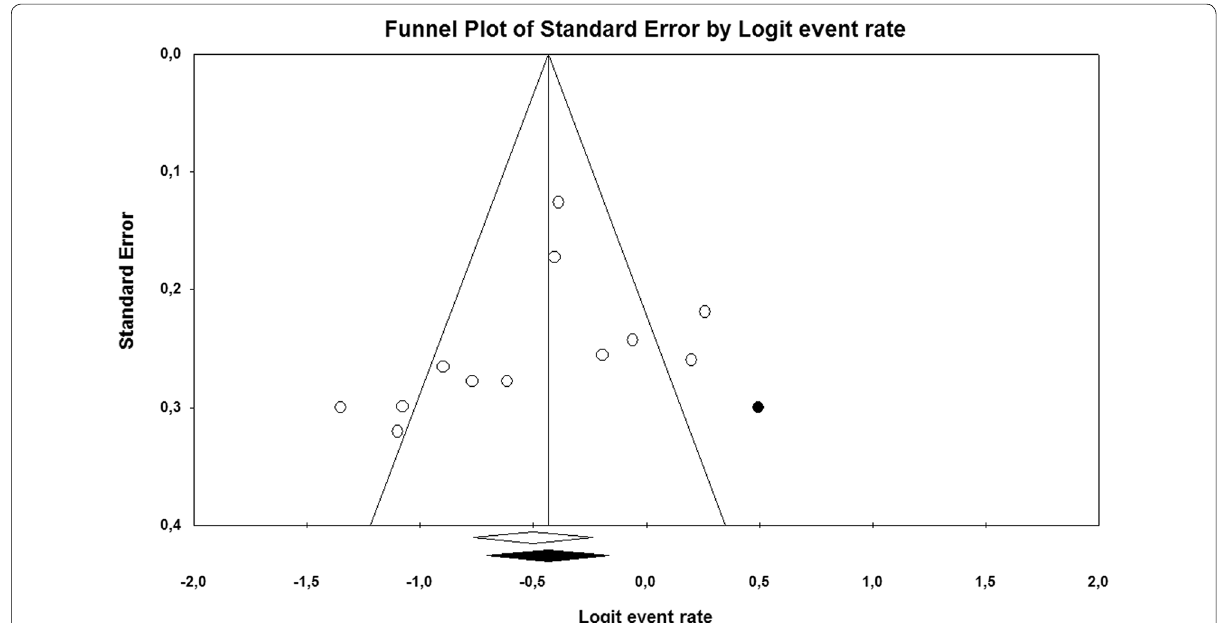
Fig. 2 Funnel plot of included studies. White circles represent observed studies. Mean point was computed using a random effects model and is presented as white rhomboid. Using the Trim and Fill method, one additional imputable study was identified. The estimated corrected mean point with confidence interval is presented as a black rhomboid